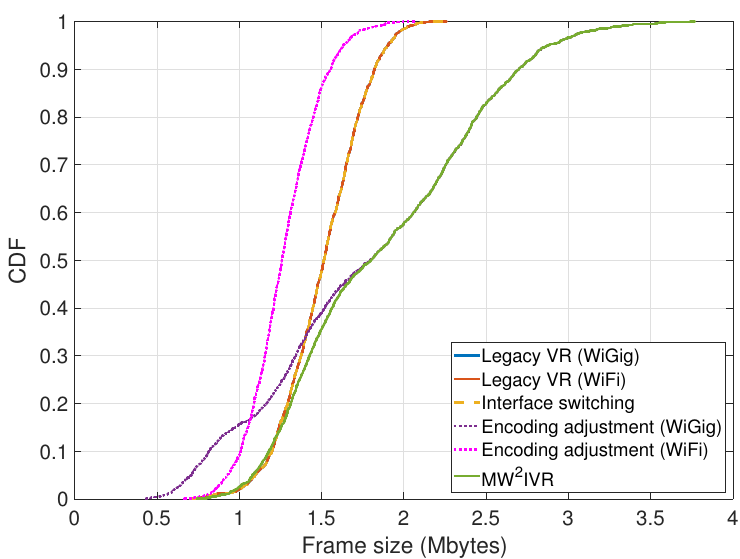
Figure 13. Cumulative distribution function of the generated and delivered frame